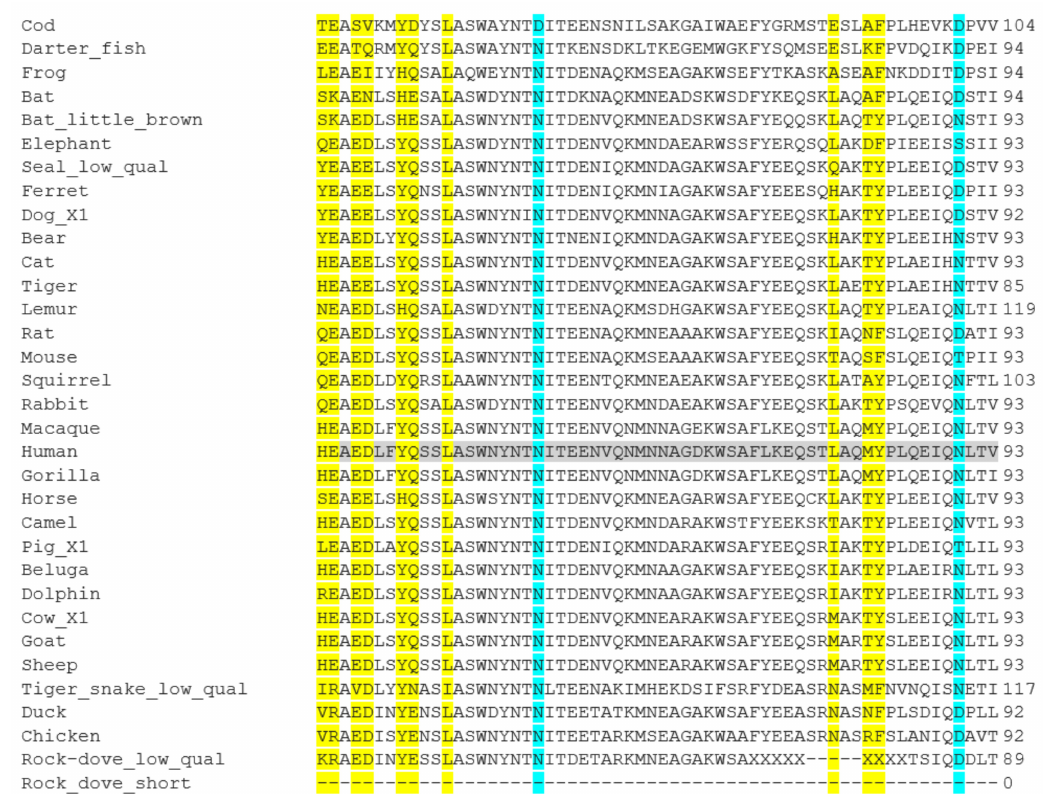
Figure 1. Amino acid sequence alignment of ACE2 polypeptides from a range of animal species: a short section encom- passing two of the glycosylation sites is shown here. Full sequence alignments are shown in Supplementary Figure S1. Accession Numbers of the polypeptide sequences used are given in Table 1. Alignments were carried out using Clustal Omega [45]. Human sequence is highlighted in grey to aid comparison to other sequences. Important amino acids used for interaction with the SARS-CoV-2 viral proteins as reported by Damas et al. [41] (Table 2) are highlighted in yellow, with the highlighted glycosylated residues in